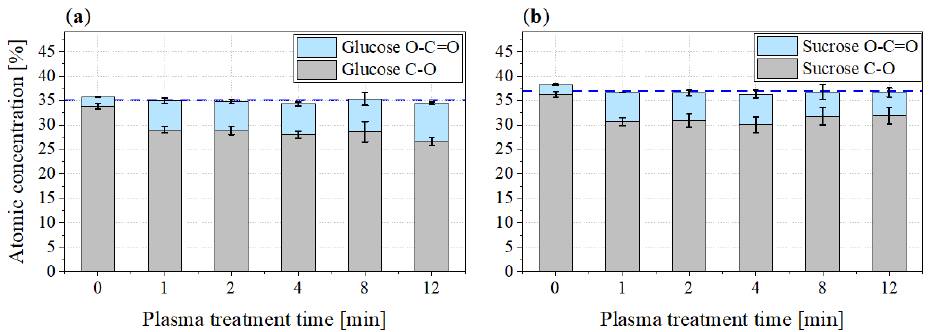
Figure 11. Stacked bar charts of the atomic concentrations of C-O bonds (grey) and O-C=O bonds (blue) of ( a ) glucose and ( b )